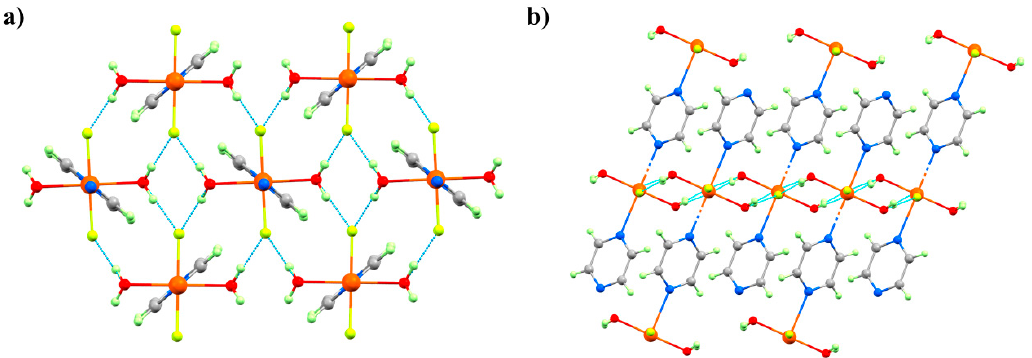
Figure 15. The molecular structure of complex 12 showing ( a ) the 2D network in the bc -plane, and ( b ) the 1D chains directed by the pyz ligands along the a -axis. The dashed light blue lines highlight the Cu–OH ··· F–Cu H-bonds. Colour code: Cu = orange, O = red, N = blue, C = grey, F = yellow, H = pale green.